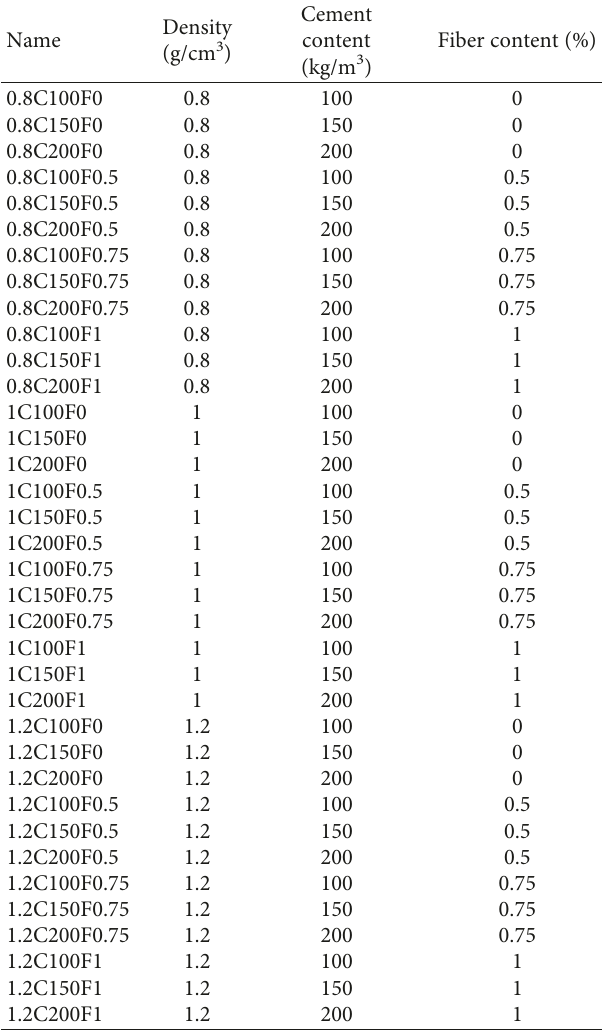
Table 2: Mixed design in the testing